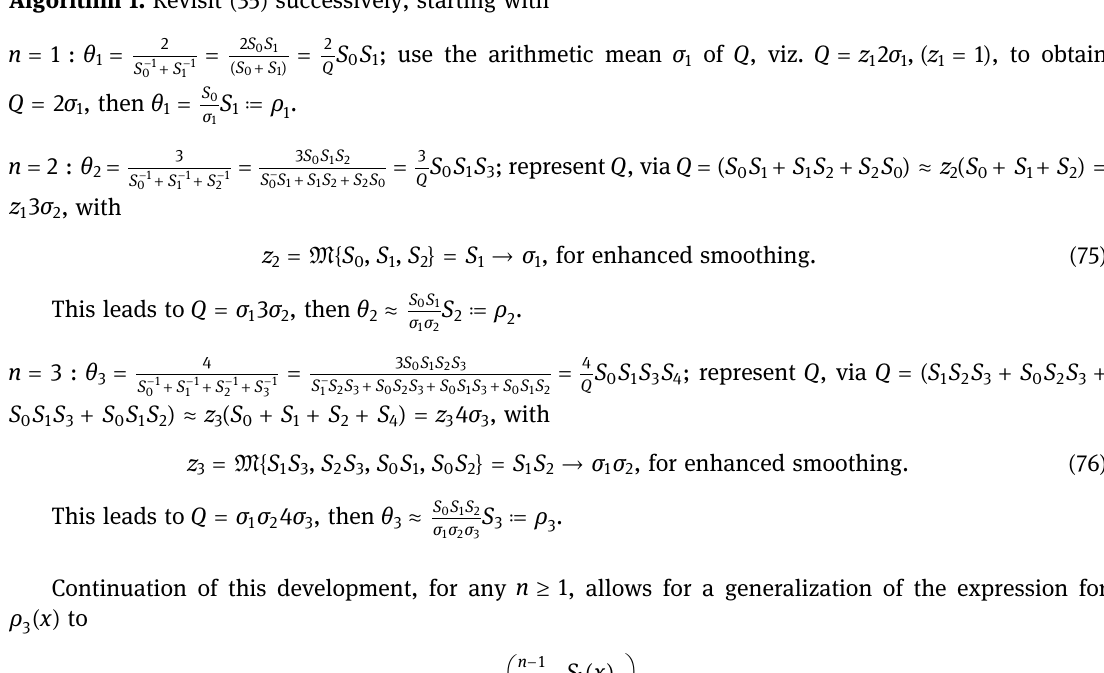
Algorithm 1. Revisit ( 35 ) successively, starting